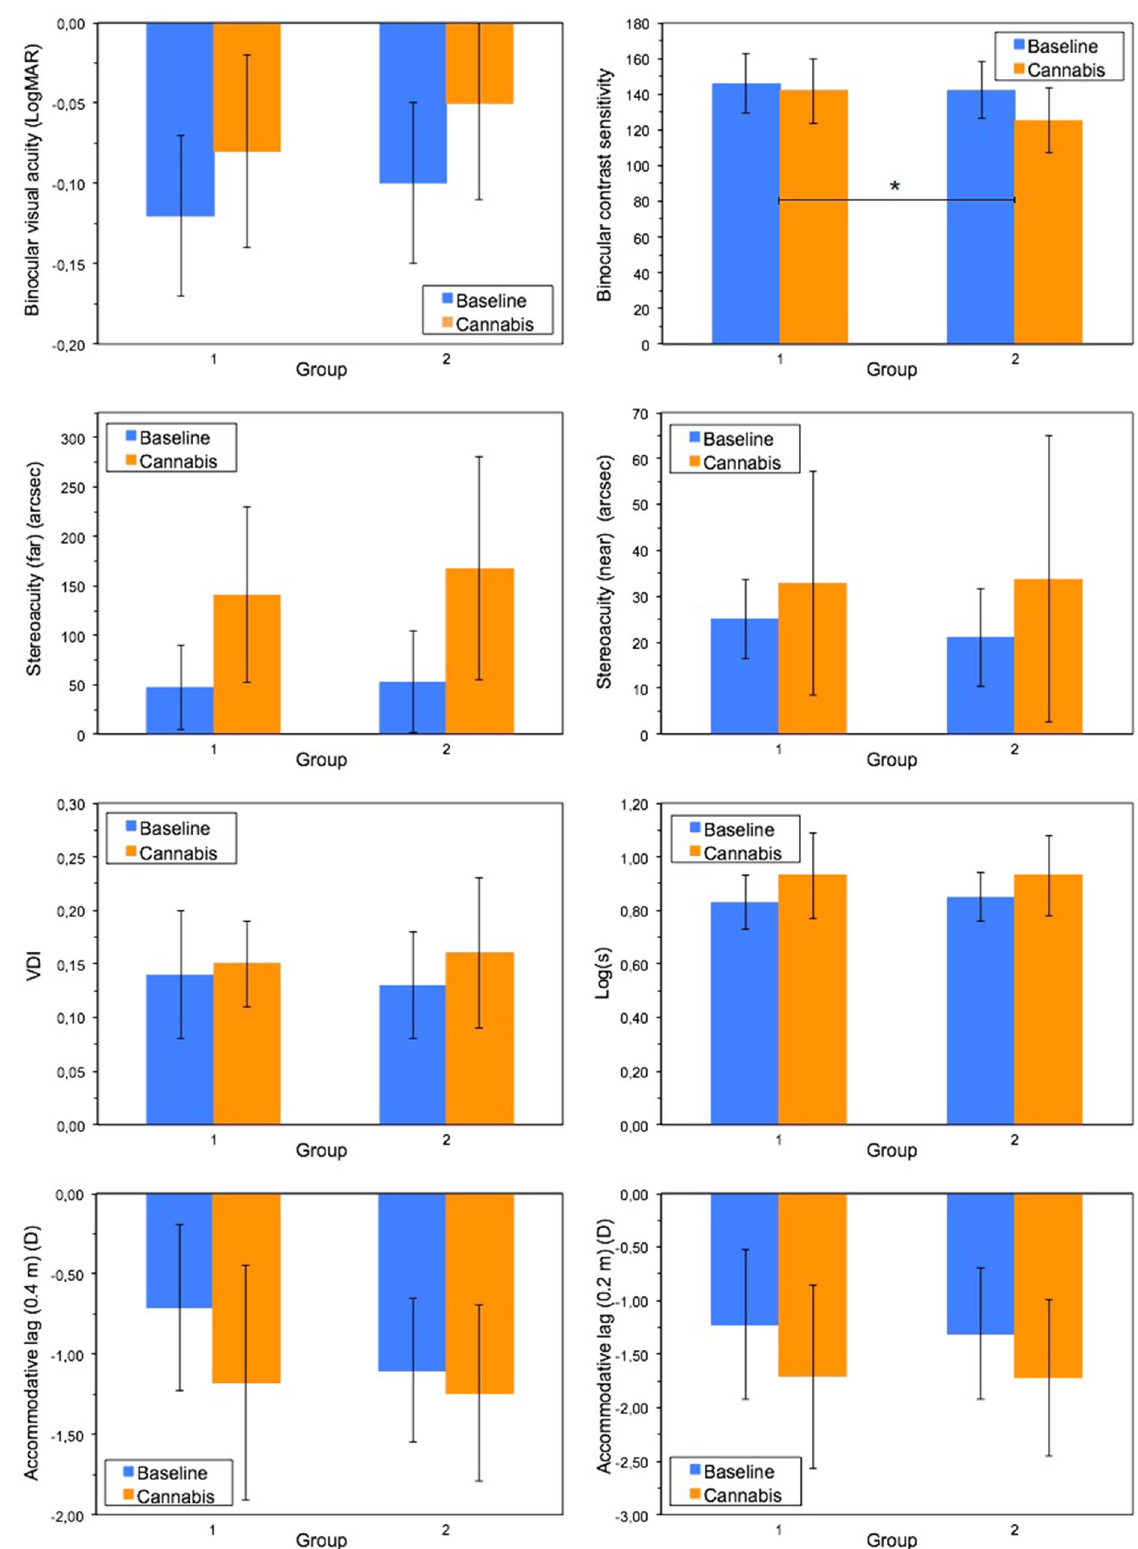
Figure 3. Group comparison for the different visual parameters in the baseline session and after smoking cannabis. * Indicates that the decline after smoking was significantly higher in group 2 than group